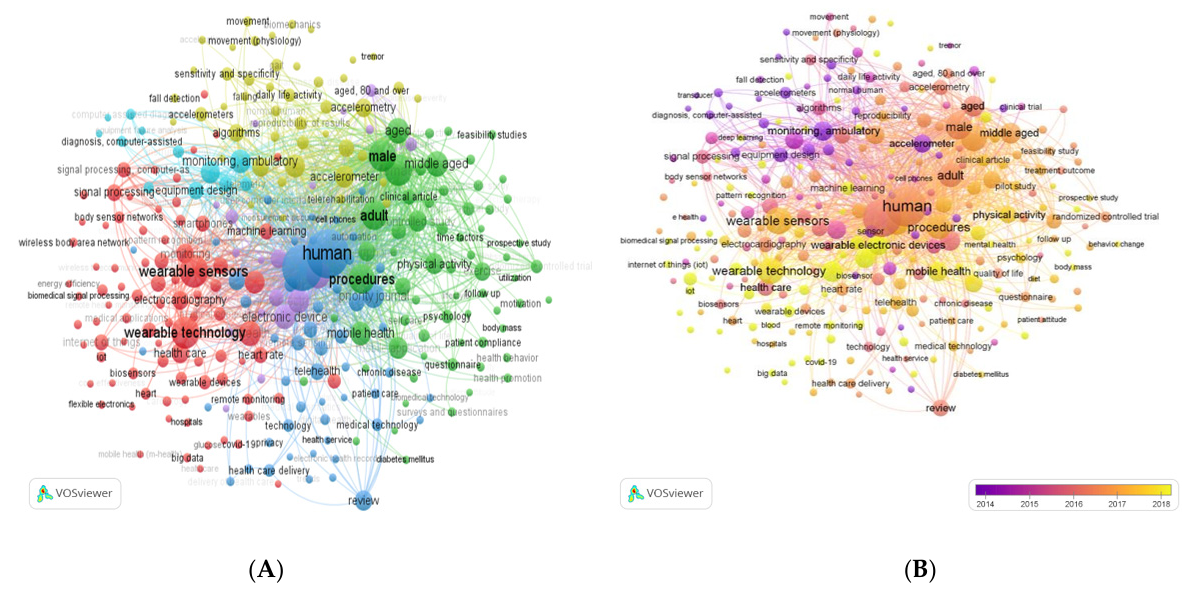
Figure 8. ( A ). Cluster view of frequent keywords in the WTH research field from 2000 to 2021**. Each of the colors within the figure represents a category and keywords that have the same color belong to the same cluster. The keywords “humans” and “article” were removed. “Humans” because it is also presented in the singular “human” and “article” because it is a frequently repeated word with little meaning in this context. The minimum number of occurrences per keyword was kept at 10. ( B ). Distribution of keywords based on year of appearance. ** Data retrieval for this research was carried out at the end of the year 2021.